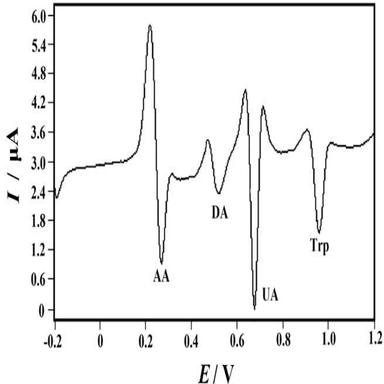
CV of 10 μM Trp + 1.0 mM AA + 10 μM DA + 10 μM UA in 0.02 M H3PO4 solution on the Ni NPs/N-C/CPE after accumulation at 0.3 V for 90 s. Scan rate: 0.1 V s − 1 .